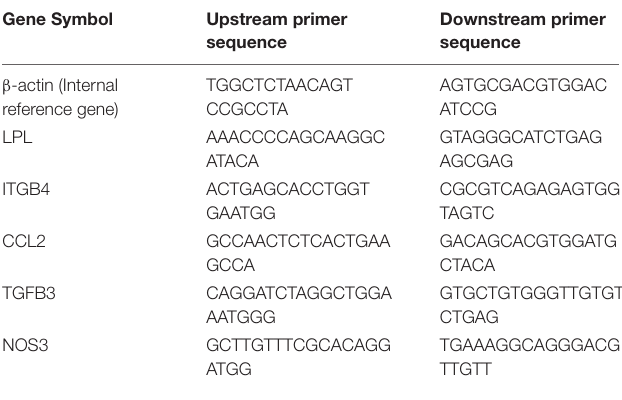
TABLE 1 | The primer sequences for mRNA